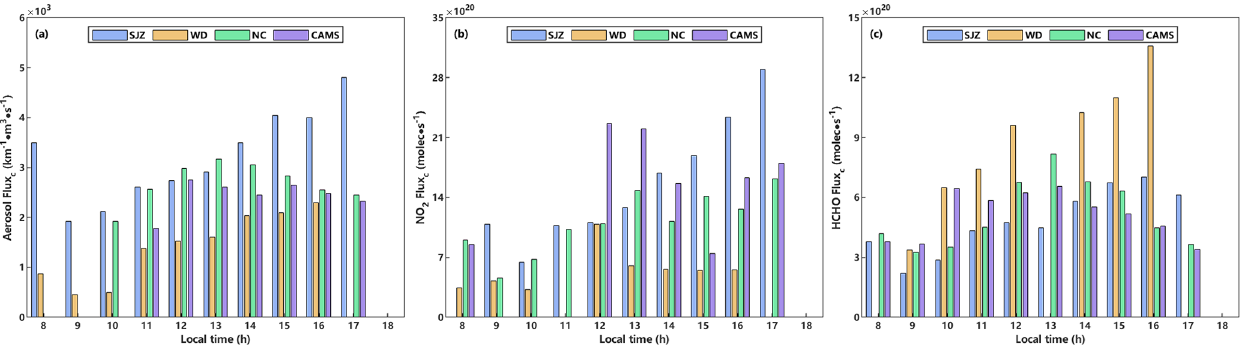
Figure 5. Diurnal variation of F c at SJZ, WD, NC, and CAMS stations for (a) AECs, (b) NO 2 , and (c) HCHO.